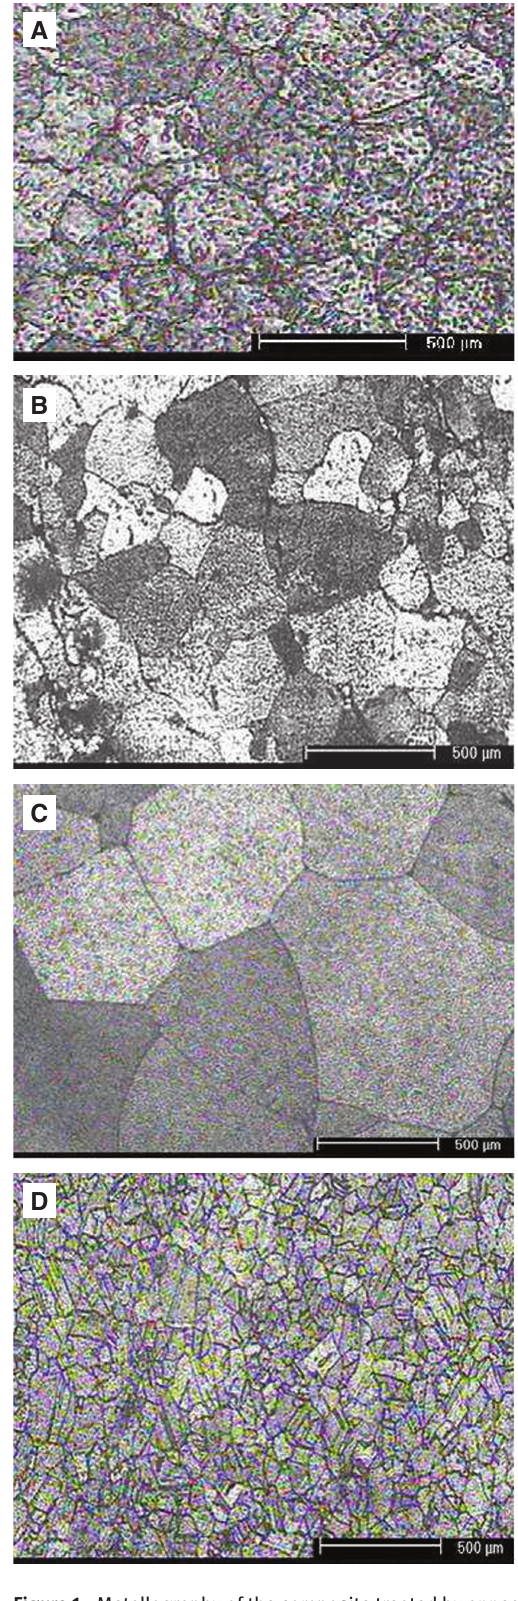
Figure 1 Metallography of the composite treated by annealing at